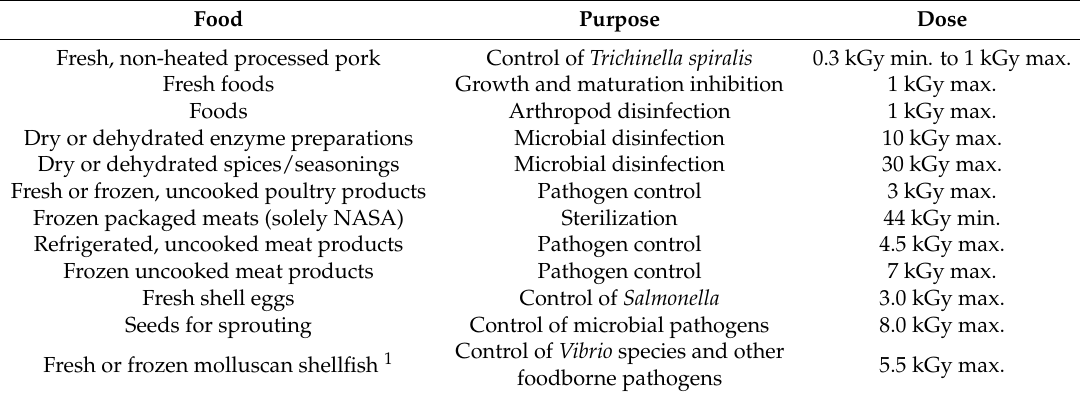
Table 1. Foods permitted to be irradiated under FDA regulations (21 CFR 179.26). Data were updated by Komolprasert